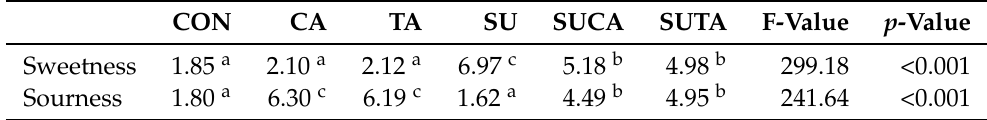
Table 3. Means and HSD letters of differences in sweetness and sourness perception between aqueous samples. F- and p -values for ANOVA model. Letters are HSD pairwise significant, and are to be read row-wise. Samples are Control (CON), Citric Acid (CA), Tartaric Acid (TA), Sucrose (SU), Sucrose, and Citric Acid (SUCA), and Sucrose and Tartaric Acid (SUTA).